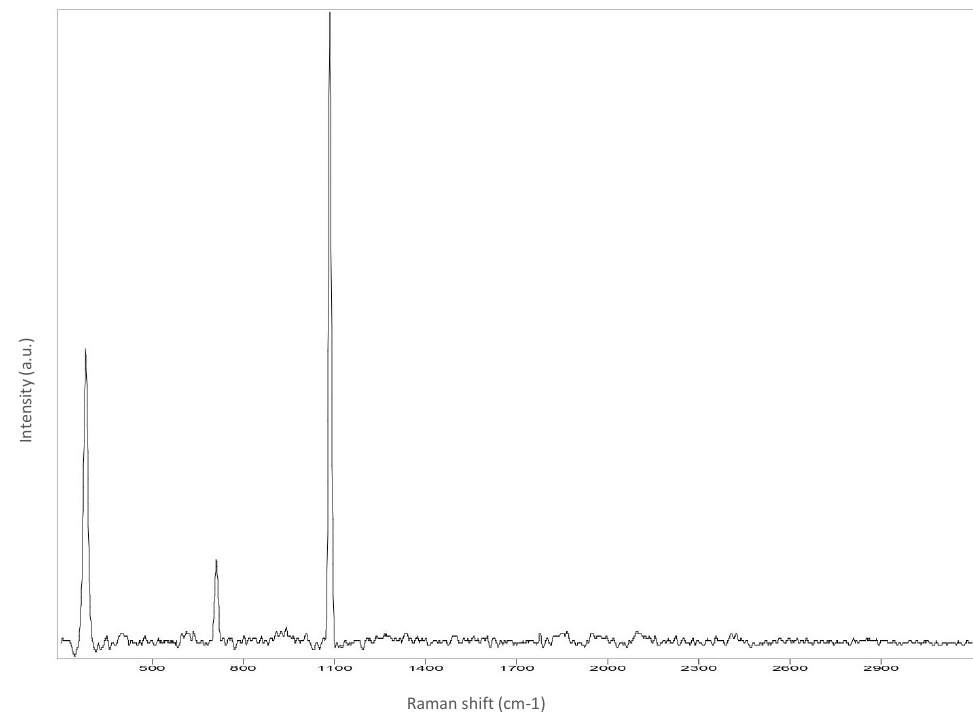
Figure A6. Hair. Figure A6. Hair.